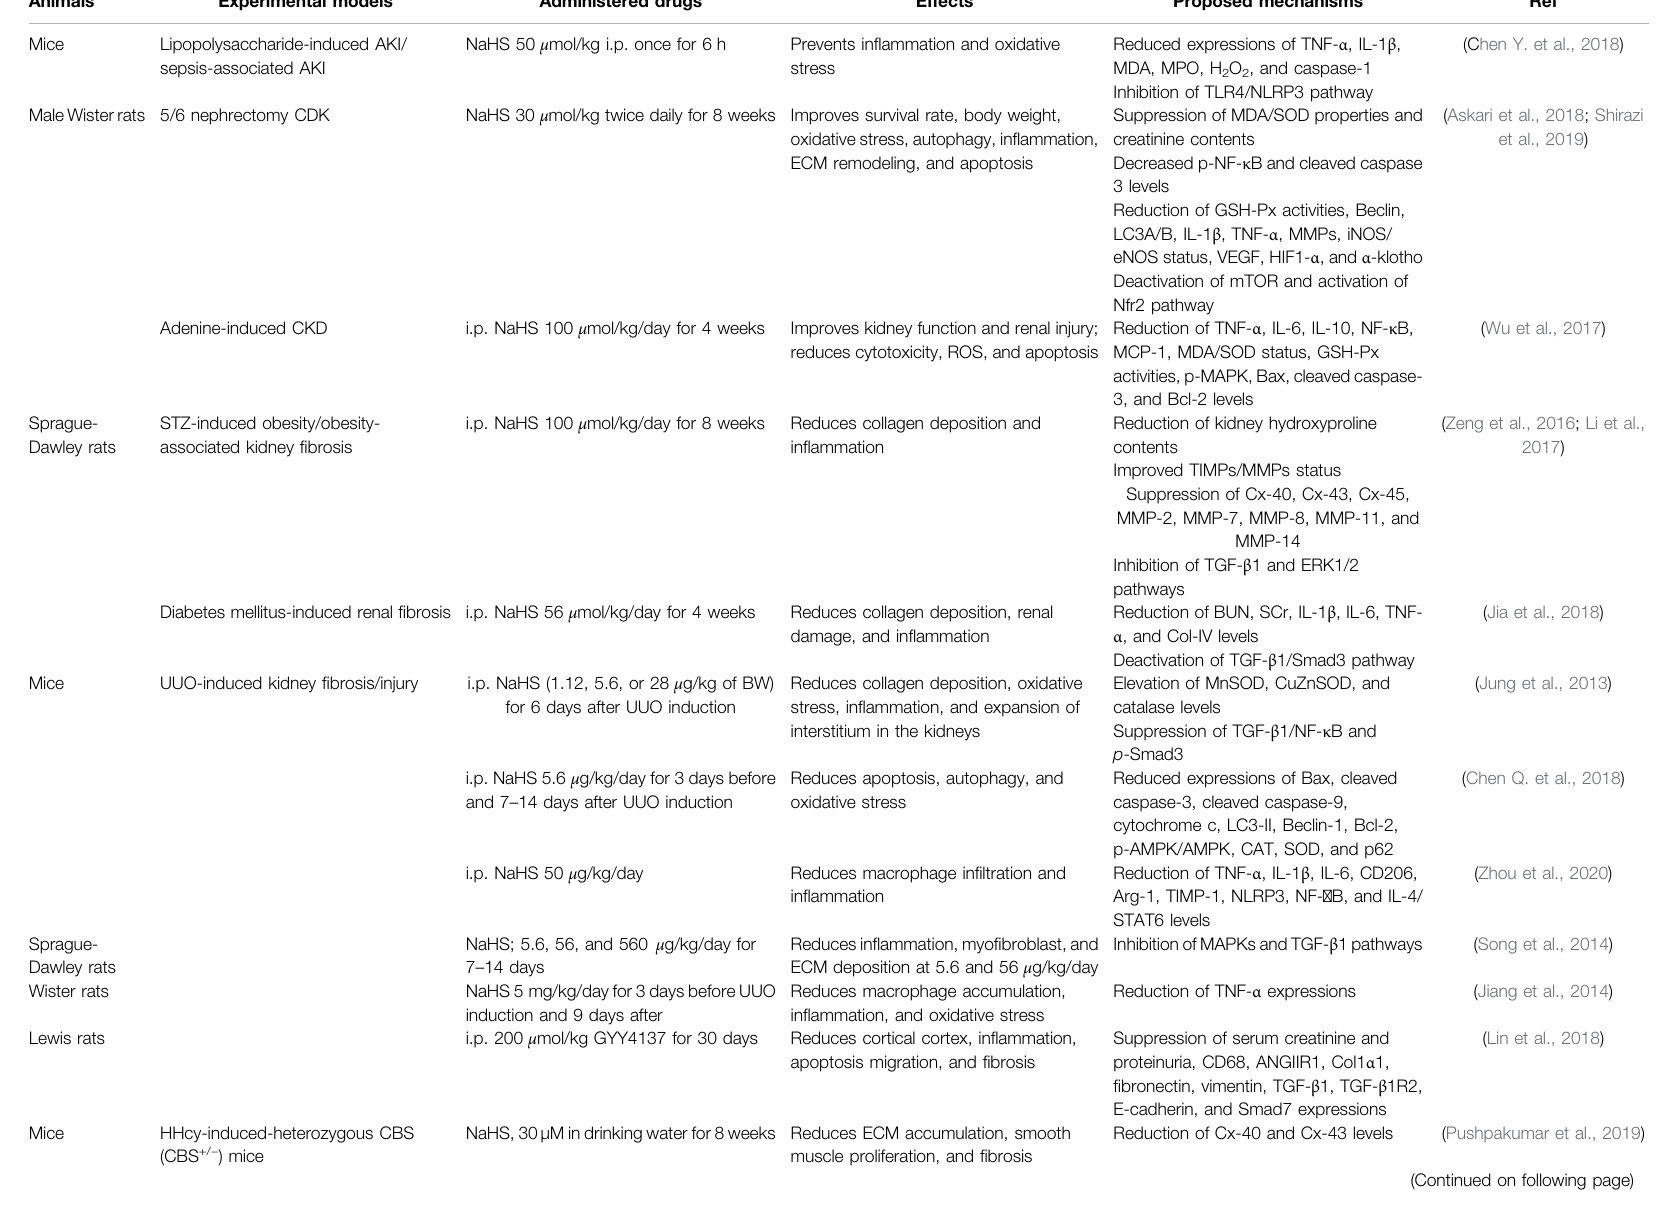
TABLE 1 | Effects of H 2 S donors on common renal diseases in animal models.